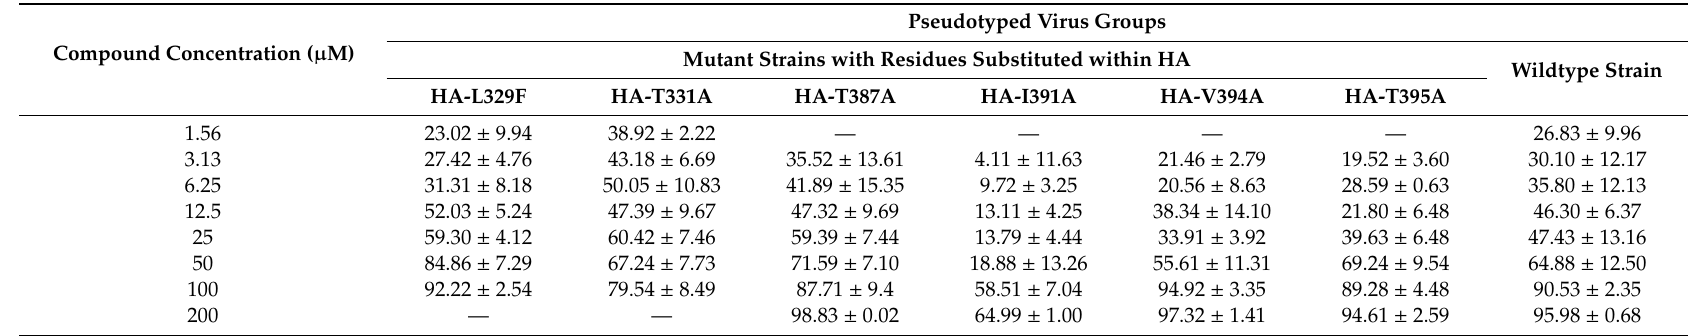
Pseudotyped Virus